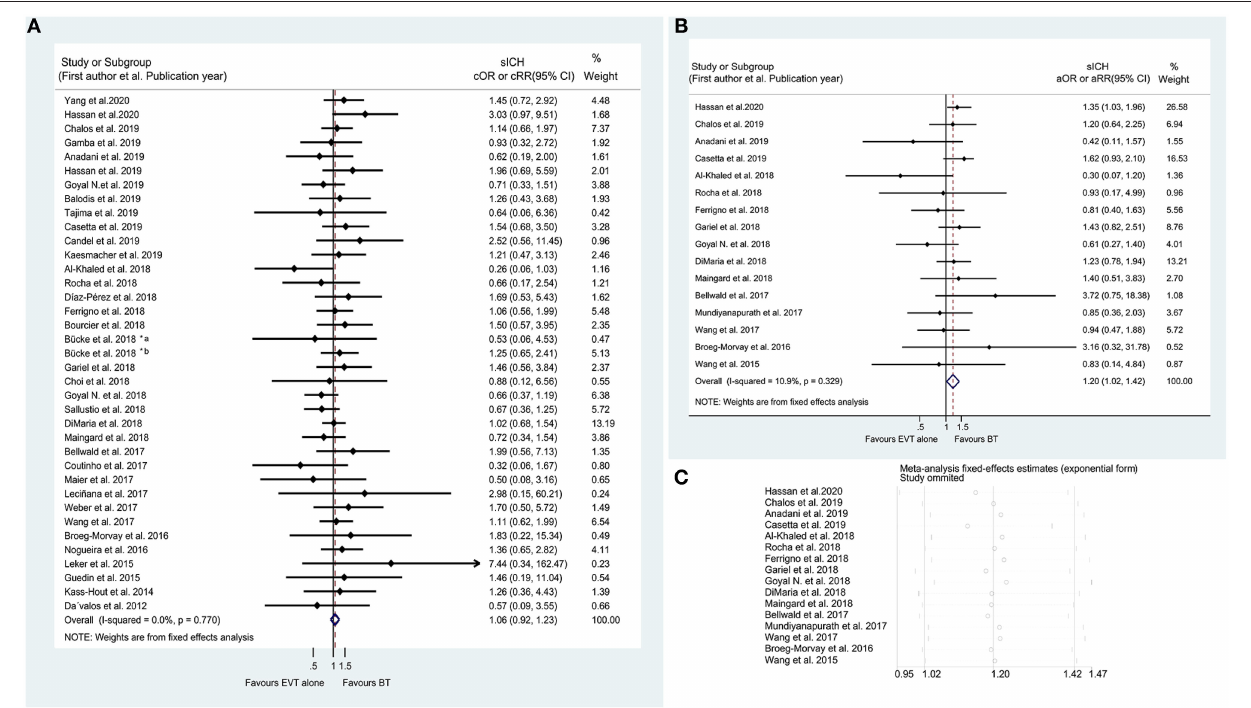
FIGURE 5 | Forest plots of studies assessing sICH in unadjusted (A) and adjusted (B) analysis with related sensitivity analysis (C) . sICH, symptomatic intracranial hemorrhage; ICA, internal carotid artery. *The acute intracranial vessel occlusion patients with (a) or without (b) concomitant ipsilateral ICA-occlusion or high-grade stenosis were investigated respectively in the study by Bücke et al.